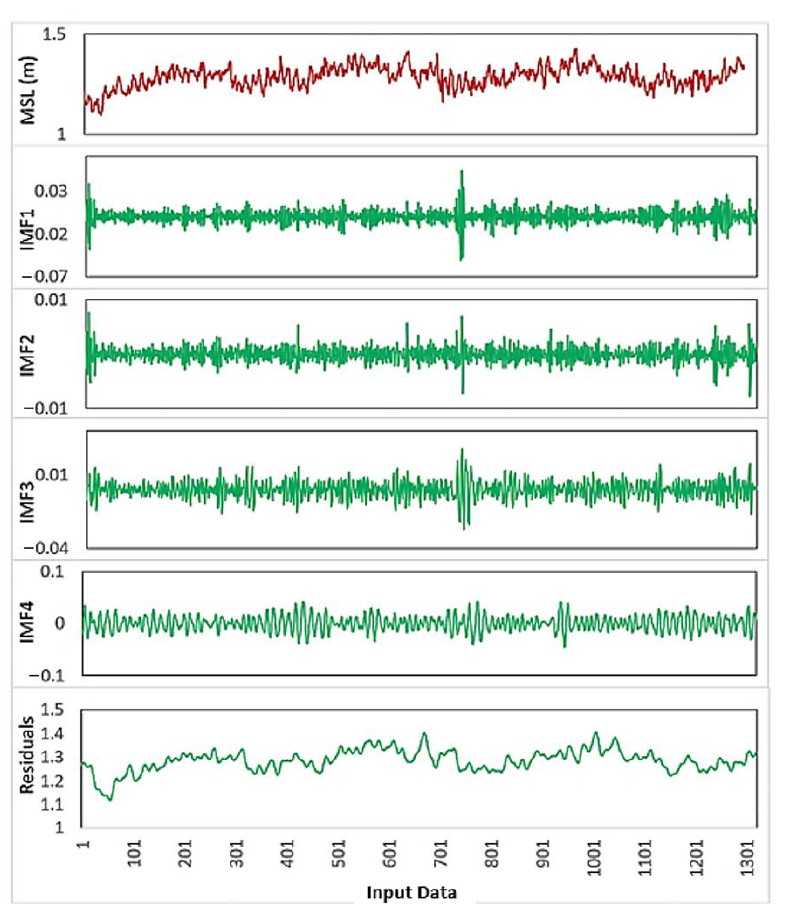
Figure 2. Time series of the intrinsic mode functions (IMFs) and the residual components after decomposing the MSL in the testing period using CEEMDAN. The time series of the actual MSL is plotted at the top of the figure.